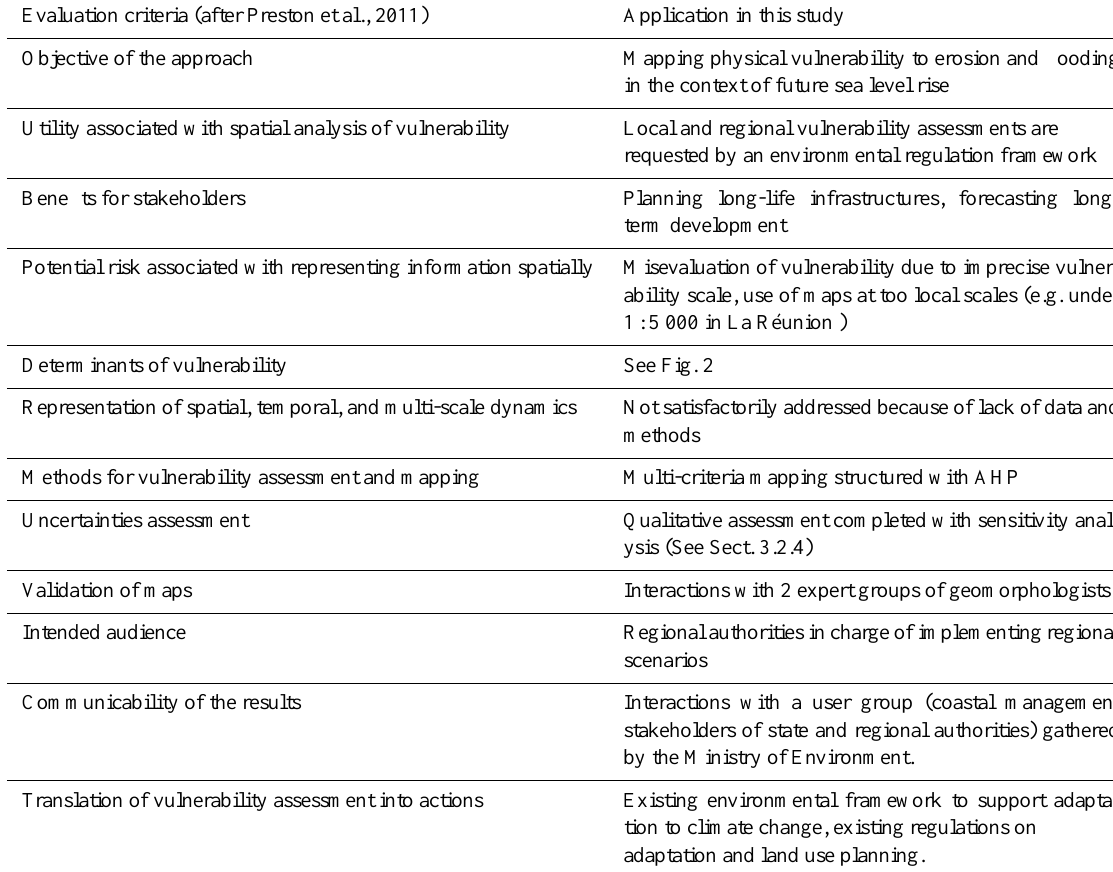
Table 7. Evaluation of the proposed